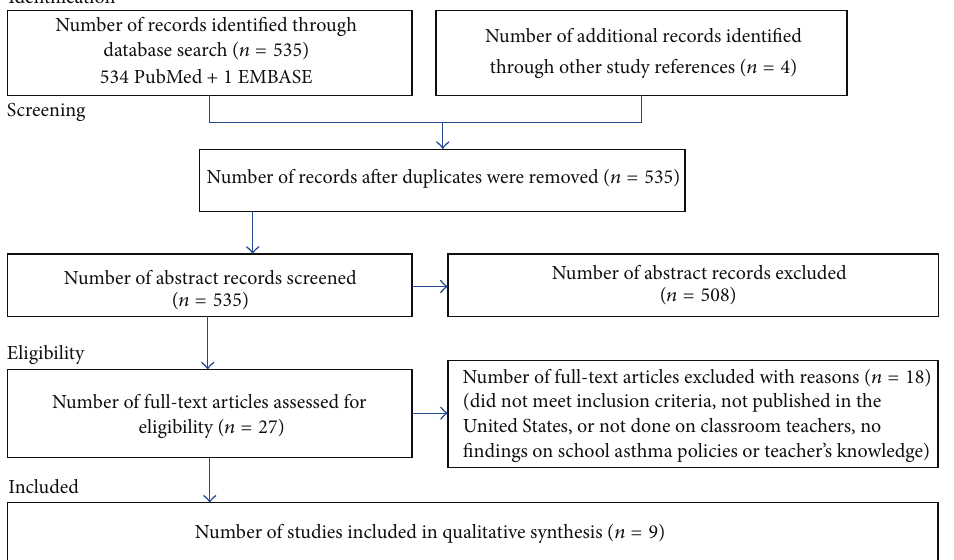
Figure 1: Flow chart of included